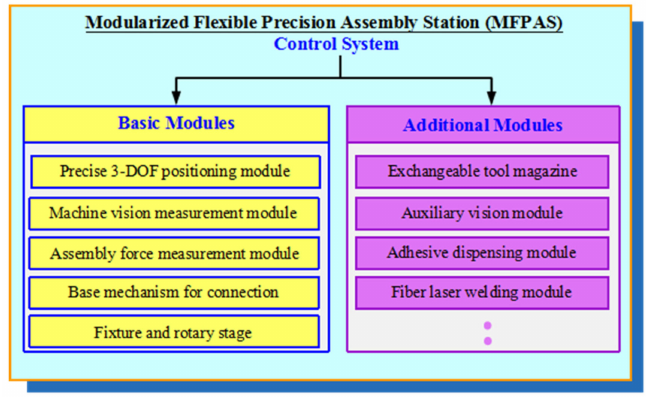
Figure 1. Division of modules of the Modularized Flexible Precision Assembly Station (MFPAS).